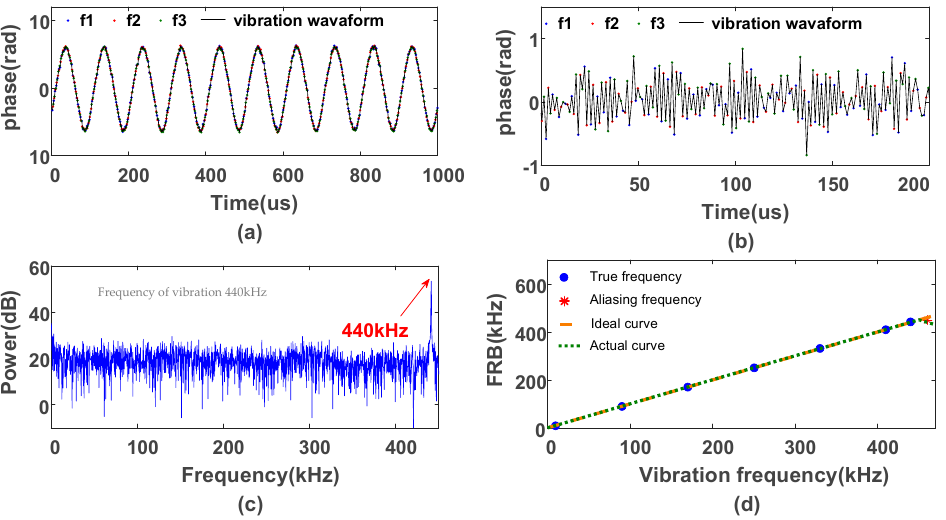
Figure 16. The detection results of the system with FDM. ( a ) Vibration signal of 10 kHz demodulated from P1 to P3; ( b ) Vibration signal of 440 kHz after interleaving algorithm; ( c ) Power spectra of 440 kHz vibration; ( d ) Detection frequency and ideal curve after interleaving algorithm.